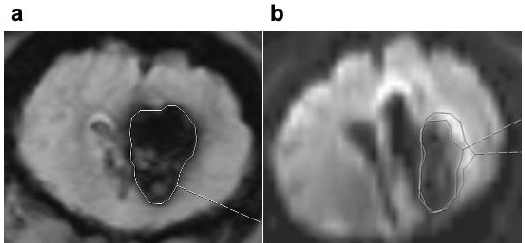
Figure 4. Cranial MRI a T2*- weighted image of ( a ) right frontal ICH white framed using the Sectra ® software (Linköping, Sweden). ( b ) DWI-image of a right frontal ICH. Diffusion restriction volume is white framed using the Sectra ® software.